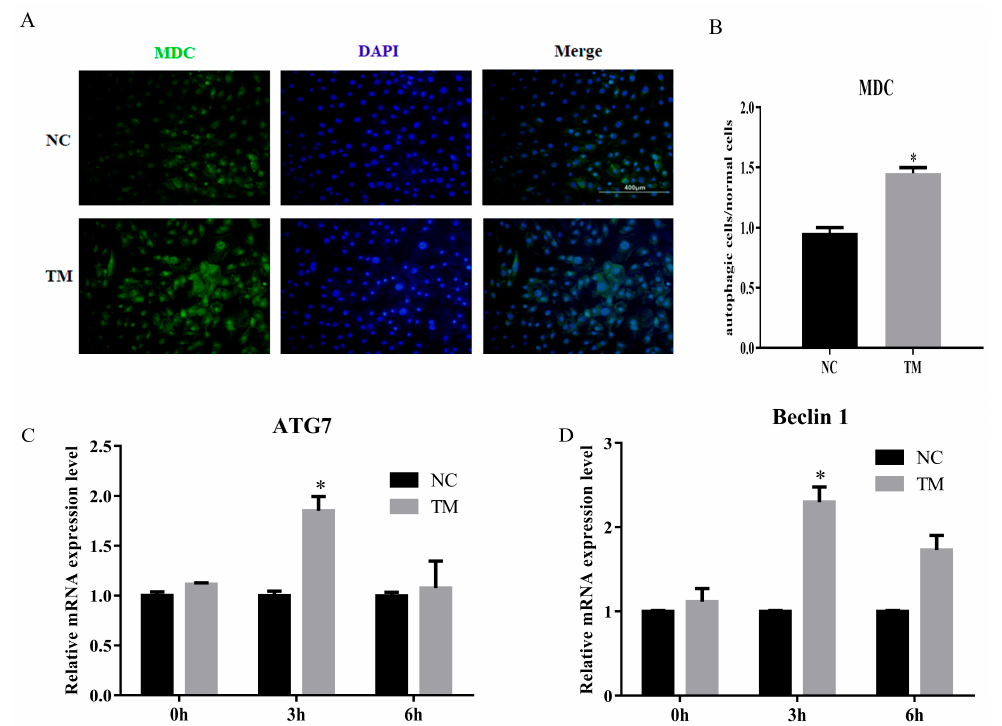
Figure 5. Autophagy model of porcine intramuscular adipocytes was constructed. ( A ) Monodansylcadaverine (MDC) staining of porcine intramuscular adipocytes after inducing autophagy by serum-free medium for 3 h. ( B ) The quantification of autophagic cells / normal cells. ( C , D ) RT-qPCR was carried out to detect the cell autophagic genes, ATG7 ( C ) and Beclin1 ( D ). Data were representative of means ± SEM of three independent experiments. *, p < 0.05. NC, negative control; TM, treatment.